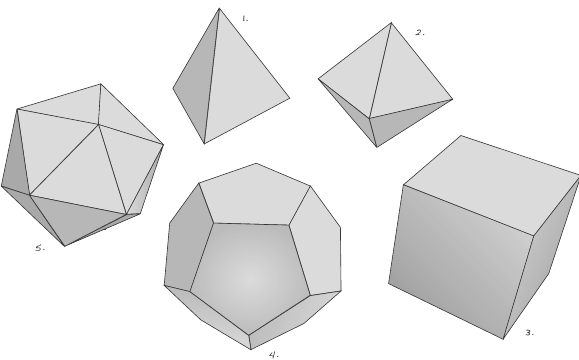
Figure 1. The Platonic solids: 1. tetrahedron; 2. octahedron; 3. cube (or hexahedron); 4. dodecahedron; and 5.